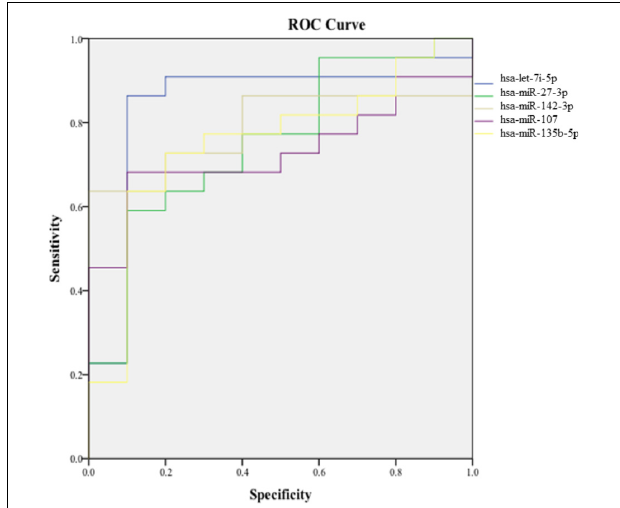
FIGURE 4 | Area under the curve of the five candidate miRNA biomarkers. Receiver-operating characteristic (ROC) curve and corresponding area under the curve (AUC) for biomarkers identified in the validation